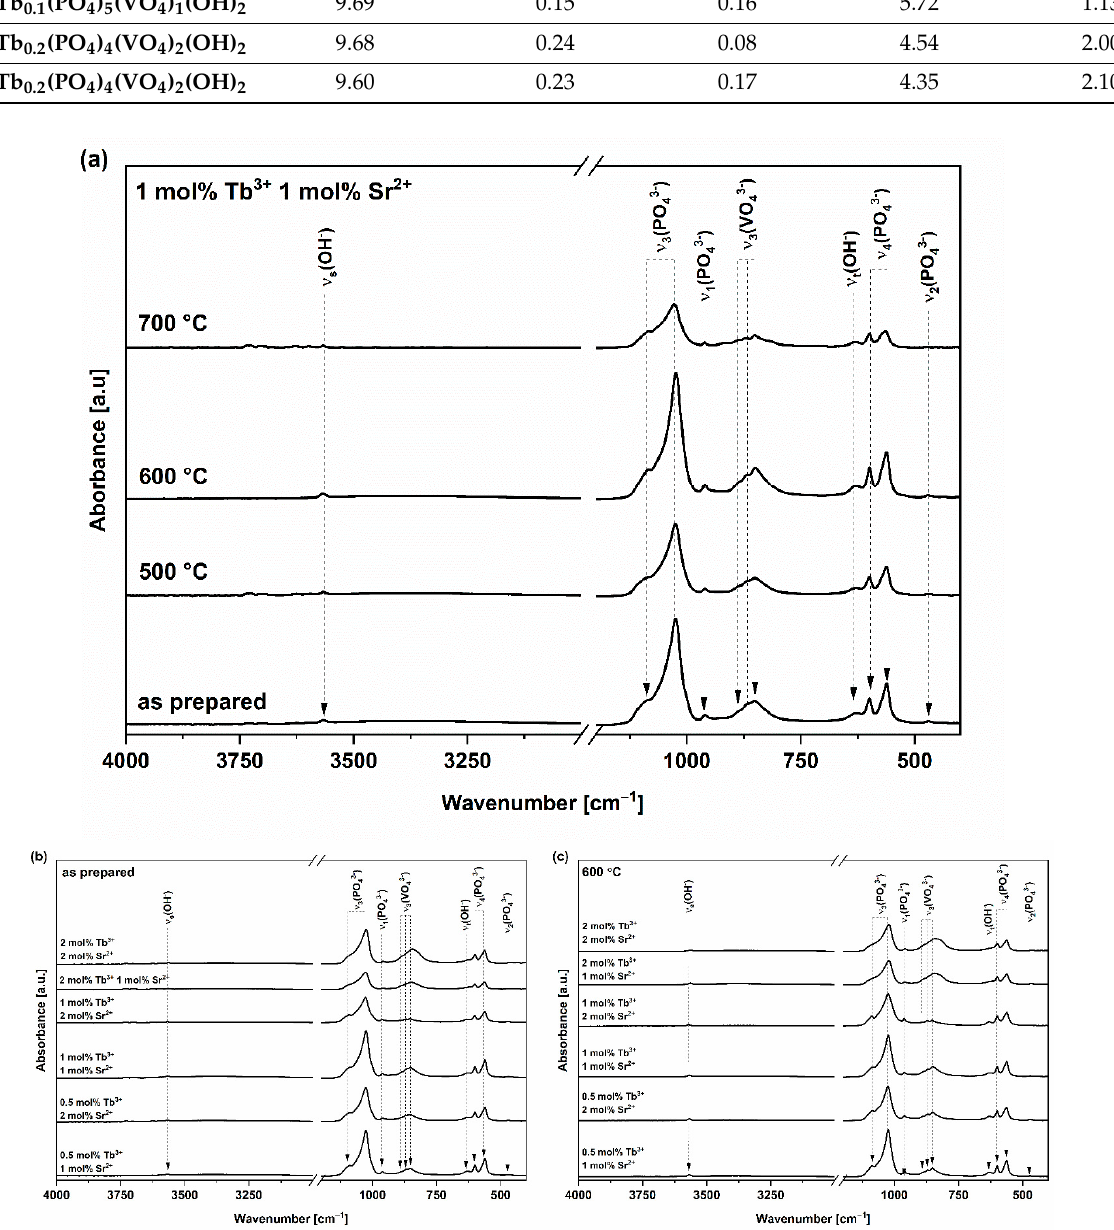
Figure 4. ( a ) ATR-FT-IR spectra of HVp co-doped with 1 mol% Sr 2+ and 1 mol% Tb 3+ ions: sample thermally untreated (as prepared) and annealed at 500, 600 and 700 °C. ( b , c ) ATR-FT-IR spectra recorded for ( b ) thermally untreated materials (as prepared) and ( c ) materials annealed at 600 °C. In the case of the spectra (Figure 4a) measured for the material co-doped with 1 mol% Tb 3+ and 1 mol% Sr 2+ annealed at 600 °C, the bands characteristic of the phosphate group are located at 560, 600, 960, 1024 and 1086 cm − 1 [17]. The bands at 560 cm − 1 and 600 cm − 1 can be assigned to the triple-degenerated stretching mode, ν 4 (PO 43 − ). The band at 960 cm − 1 originates from the non-degenerated symmetric stretching mode, ν 1 (PO 43 − ) [59]. The 1024 cm − 1 and 1086 cm − 1 bands correspond to the triple-degenerated antisymmetric stretching mode, ν 3 (PO 43 − ) [59]. The vanadate group is represented by the bands at 849, 870 and 887 cm − 1 , which originate from the symmetrical stretching mode, ν 3 (VO 43 − ) [60,61]. Addition- ally, a band with an assignment that is not straightforward appears at 469cm − 1 . In the 400– 500 cm − 1 range, bands can be attributed to modes originating from both phosphate and vanadate groups. The reason for this is an overlap of bands originating from ν 2 (PO 43 − ), ν 2 (VO 43 − ) and ν 4 (VO 43 − ) modes [19]. The presence of the hydroxyl group is confirmed by the presence of the bands at 630 and 3567 cm − 1 [62,63]. A band originating from the sym- metrical stretching mode of the hydroxyl group is present at 3567 cm − 1 , whereas the band originating from the torsion mode of the hydroxyl group is present at 630 cm − 1 . The torsion